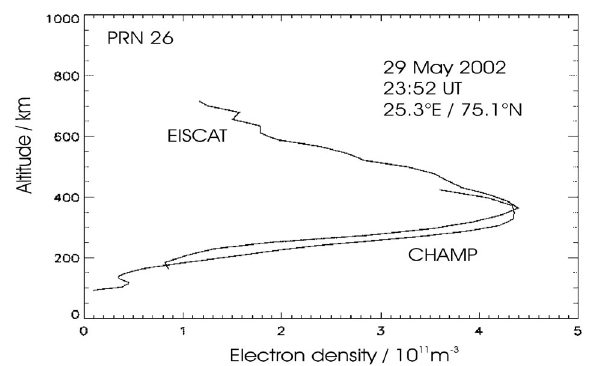
Fig. 7.5. Comparison of a CHAMP-IRO derived electron density profile with a corresponding EDP derived from EISCAT measurements on 29 May 2002, 23:52